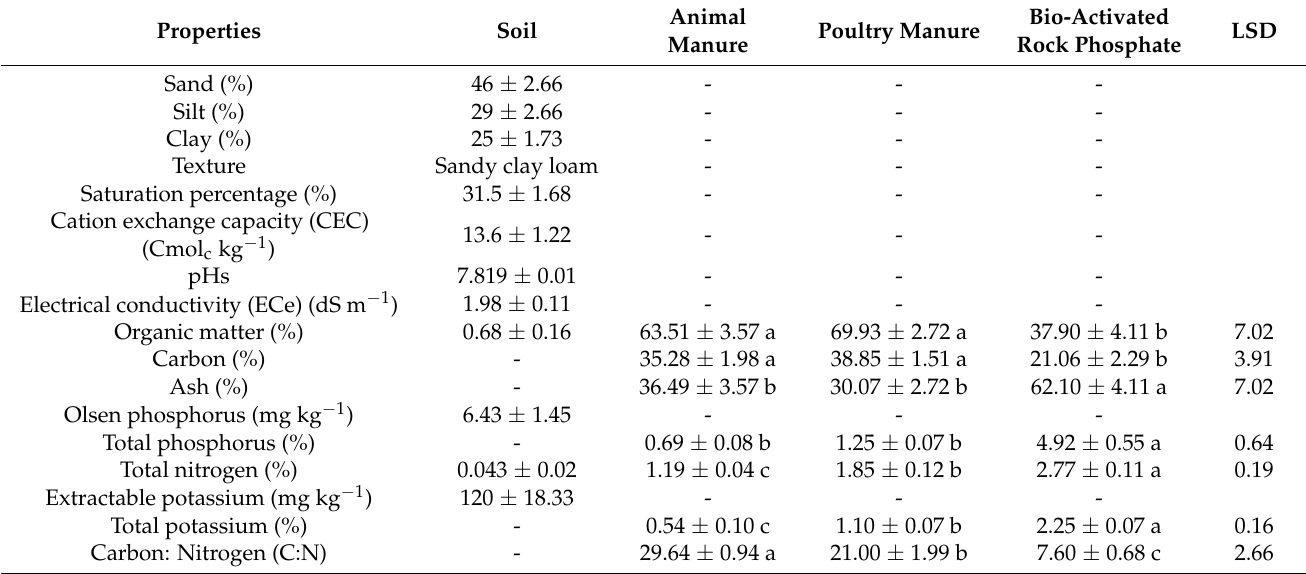
Table 1. Physico-chemical analysis of soil, organic sources and bio-activated rock